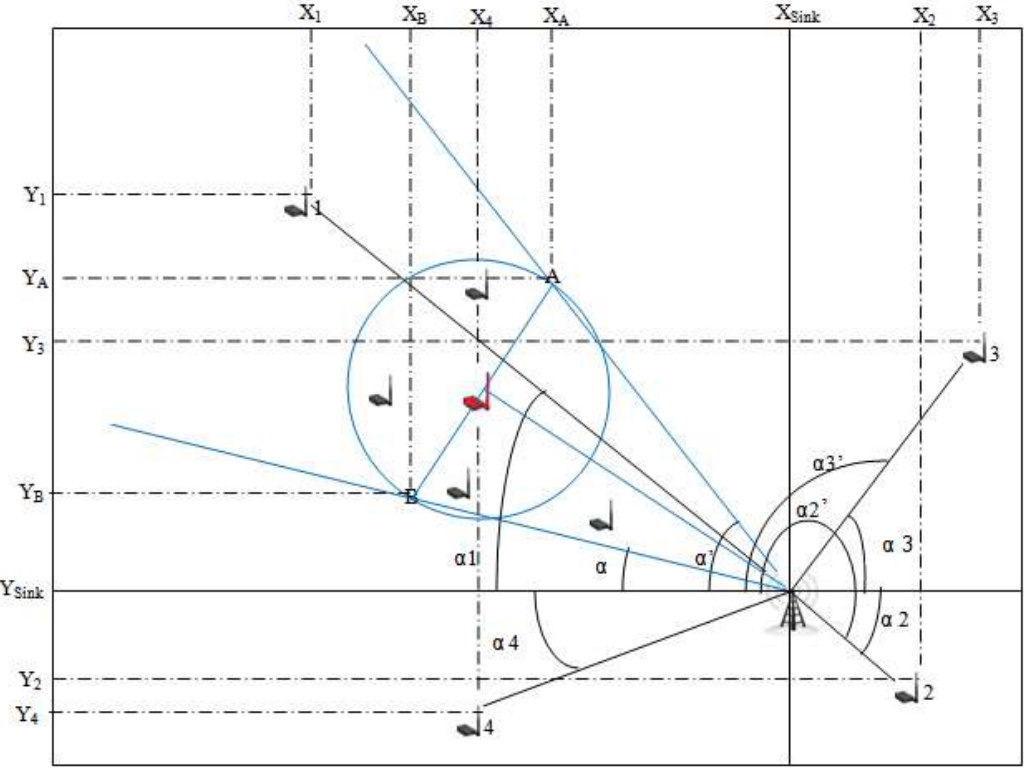
Figure 3. Verify the belonging of a sensor in a group.